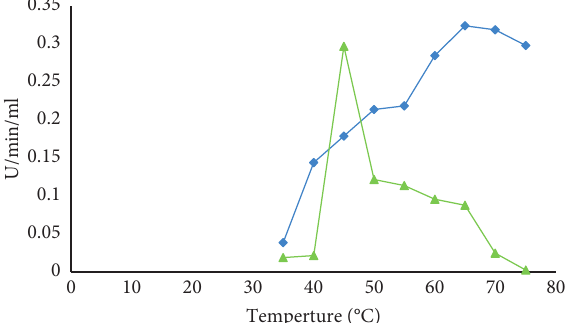
Figure 2: Optimum temperature incubation of B. licheniformis (blue) and B. cereus (green) for amylase production.